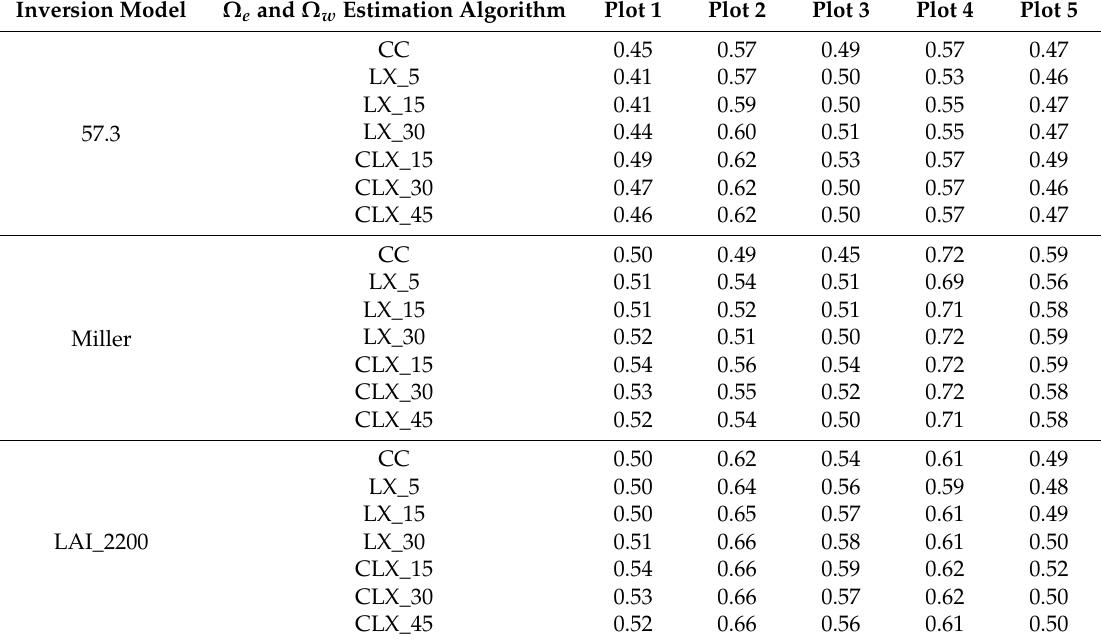
Table 7. α estimates derived with consideration of Ω e and Ω w by using the leaf-on and leaf-off periods DHP images in the five plots.